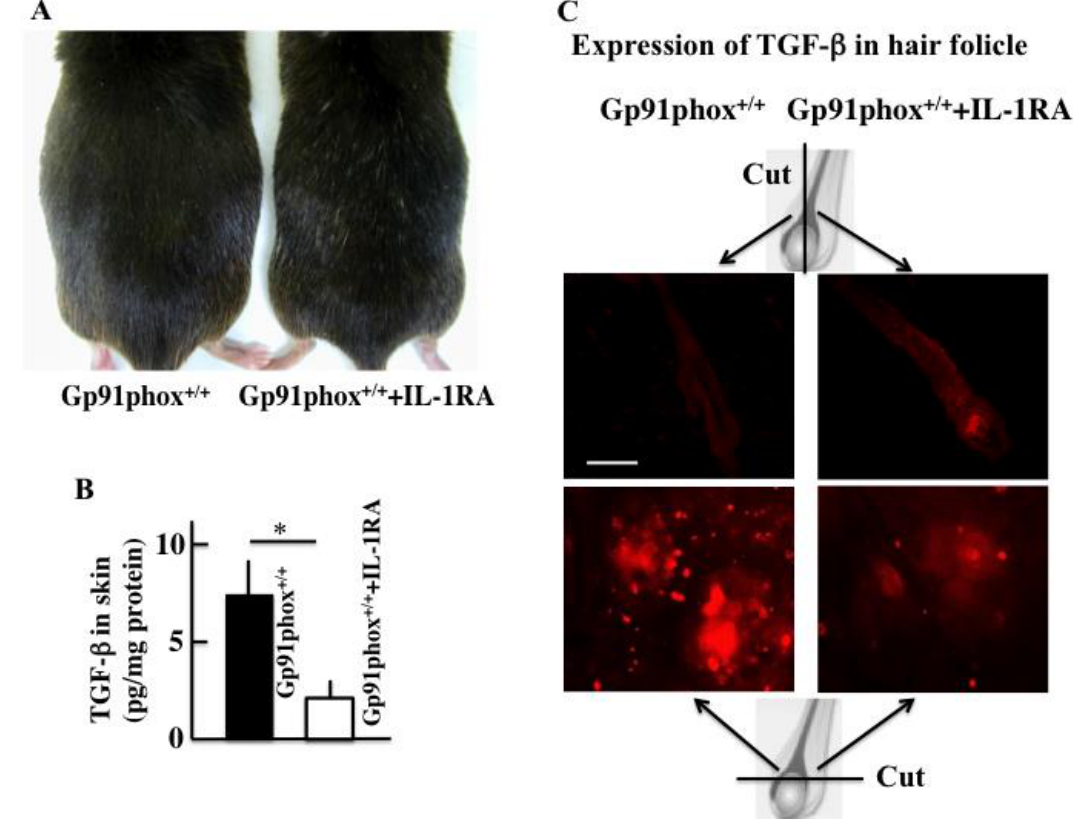
Figure 2. The effect on IL-1βRA treatment on the hair color in twelve-month-old C57BL/6j mice ( A ). The effect of IL-1βRA treatments on the plasma level TGF-β in the gp91phox −/− mice ( B ) and the expression of TGF-β in the niche of hair follicle in the dorsal skin ( C ). The data show the results from one typical experiment involving six animals. The values are expressed as mean ± SD derived from six animals. * p < 0.05. Scale bar = 10 μm.